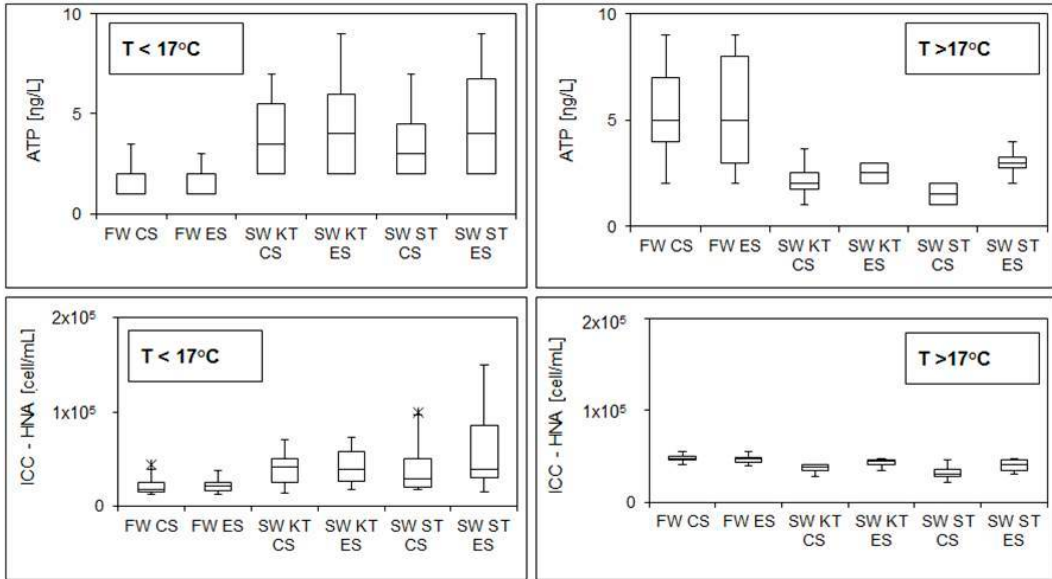
Figure 5. ATP ( up ) and ICC-HNA ( down ) concentrations in fresh water (FW) and stagnant water (SW) in the conventional (CS) and extended system (ES) at the kitchen tap (KT) and shower tap (ST). Number of fresh samples (inlet, kitchen and shower) = 48. Left : Temperature of fresh water < 17 ◦ C, number of fresh samples = 36, number of stagnant samples per tap = 12, SD ATP < 4%, SD ICC < 4%. Right : Temperature of fresh water >17 ◦ C, number of fresh samples = 12, Number of stagnant samples per tap = 4; *—outliers.